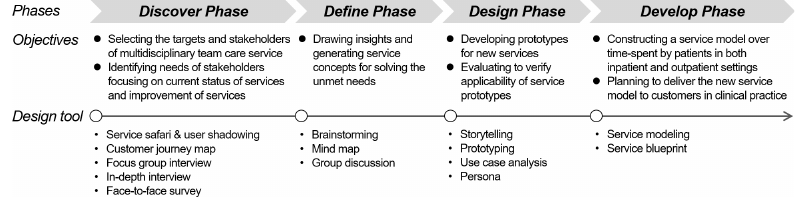
Fig 1. Service design framework for developing a collaborative multidisciplinary team care service